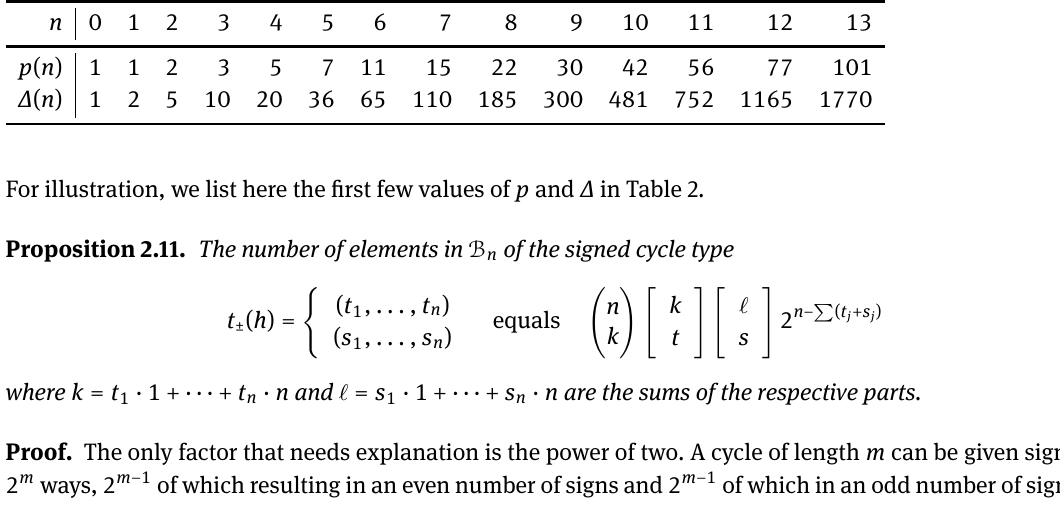
Table 2: Sequences A000041 and A000712 in the Online Encyclopedia of Integer Sequences .